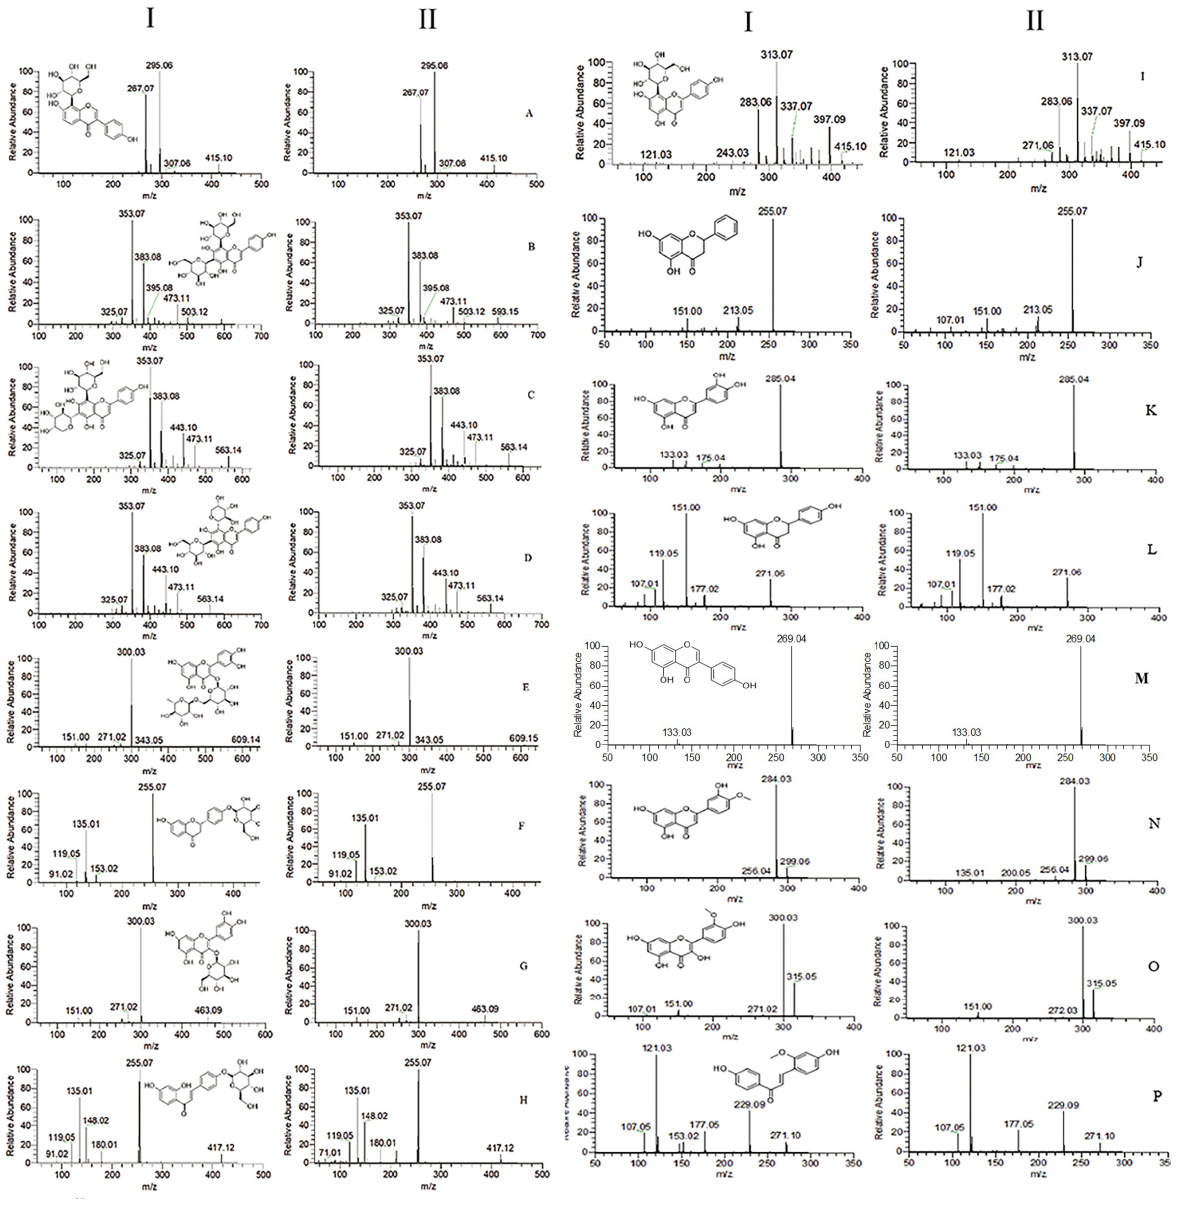
Figure 1. Spectra of 16 components in reference solution (I) and sample (II). ( A ) Puerarin; ( B ) vicenin-2; ( C ) isoschaftoside; ( D ) schaftoside; ( E ) rutin; ( F ) liquiritin; ( G ) isoquercitrin; ( H ) isoliquiritin; ( I ) vitexin; ( J ) pinocembrin; ( K ) luteolin; ( L ) naringenin; ( M ) genistein; ( N ) diosmetin; ( O ) isorhamnetin; ( P ) retrochalcone. Five prototype components (retrochalcone, kaempferol, luteolin, diosmetin and pi- nocembrin) in plasma, prostate, urine and feces can be found by analyzing the Wayne diagram of the prototype components in plasma, prostate, urine and feces (Figure 2); plasma, urine and feces had no other common components except the above five com- ponents; plasma and urine share only one prototype component (isorhamnetin); there are seven prototype components (astragalin, schaftoside, liquiritin, genistein, ononin, isoliquiritin and wogonin) in plasma and feces. The common prototype that is distributed